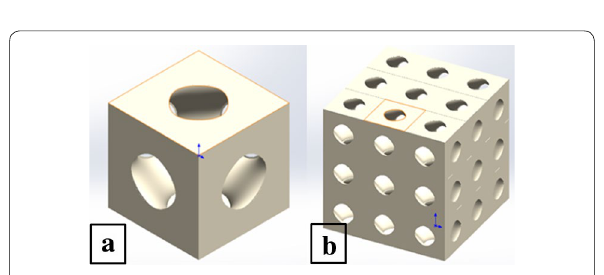
Figure 2 Solid models of bone scaffolds: a single-unit model, b 27-unit